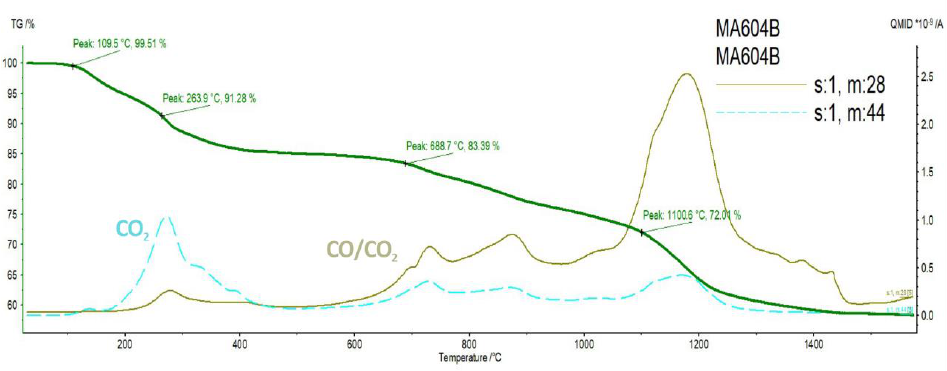
Figure 11. MA604B TGA-MS diagram.